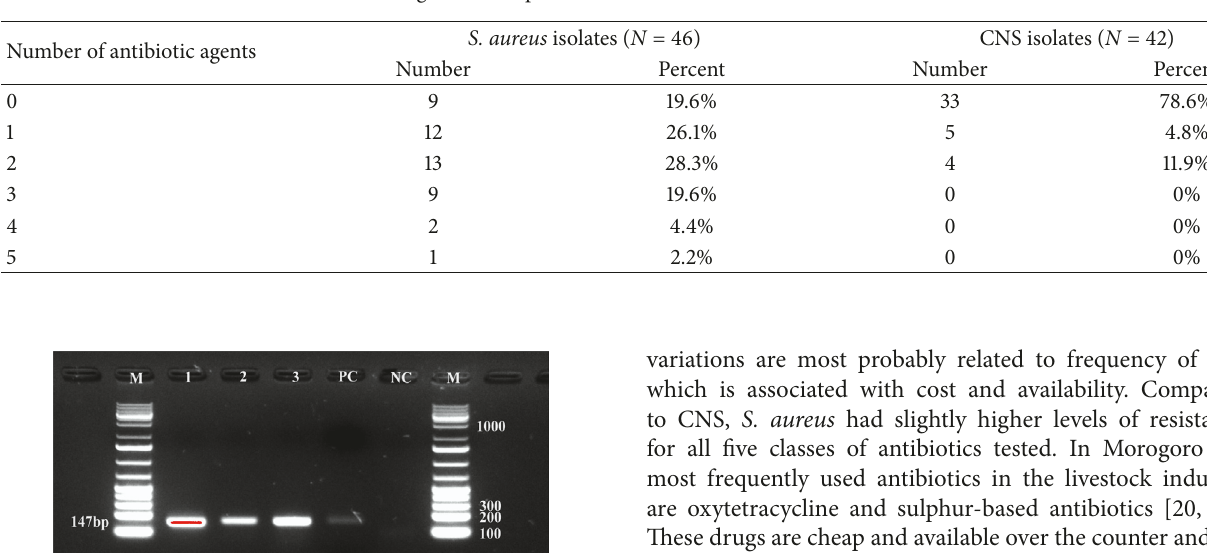
Table 4: Multidrug resistance pattern of S. aureus and CNS isolated from raw milk.